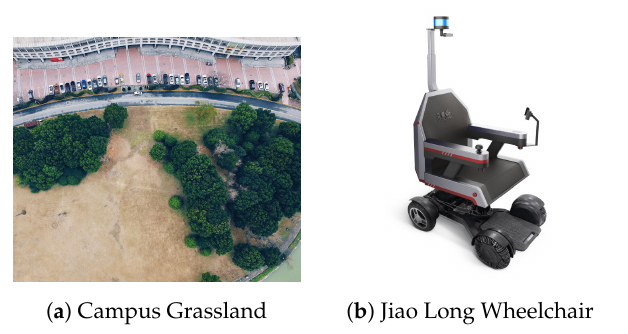
Figure 6. Platform and Environment.